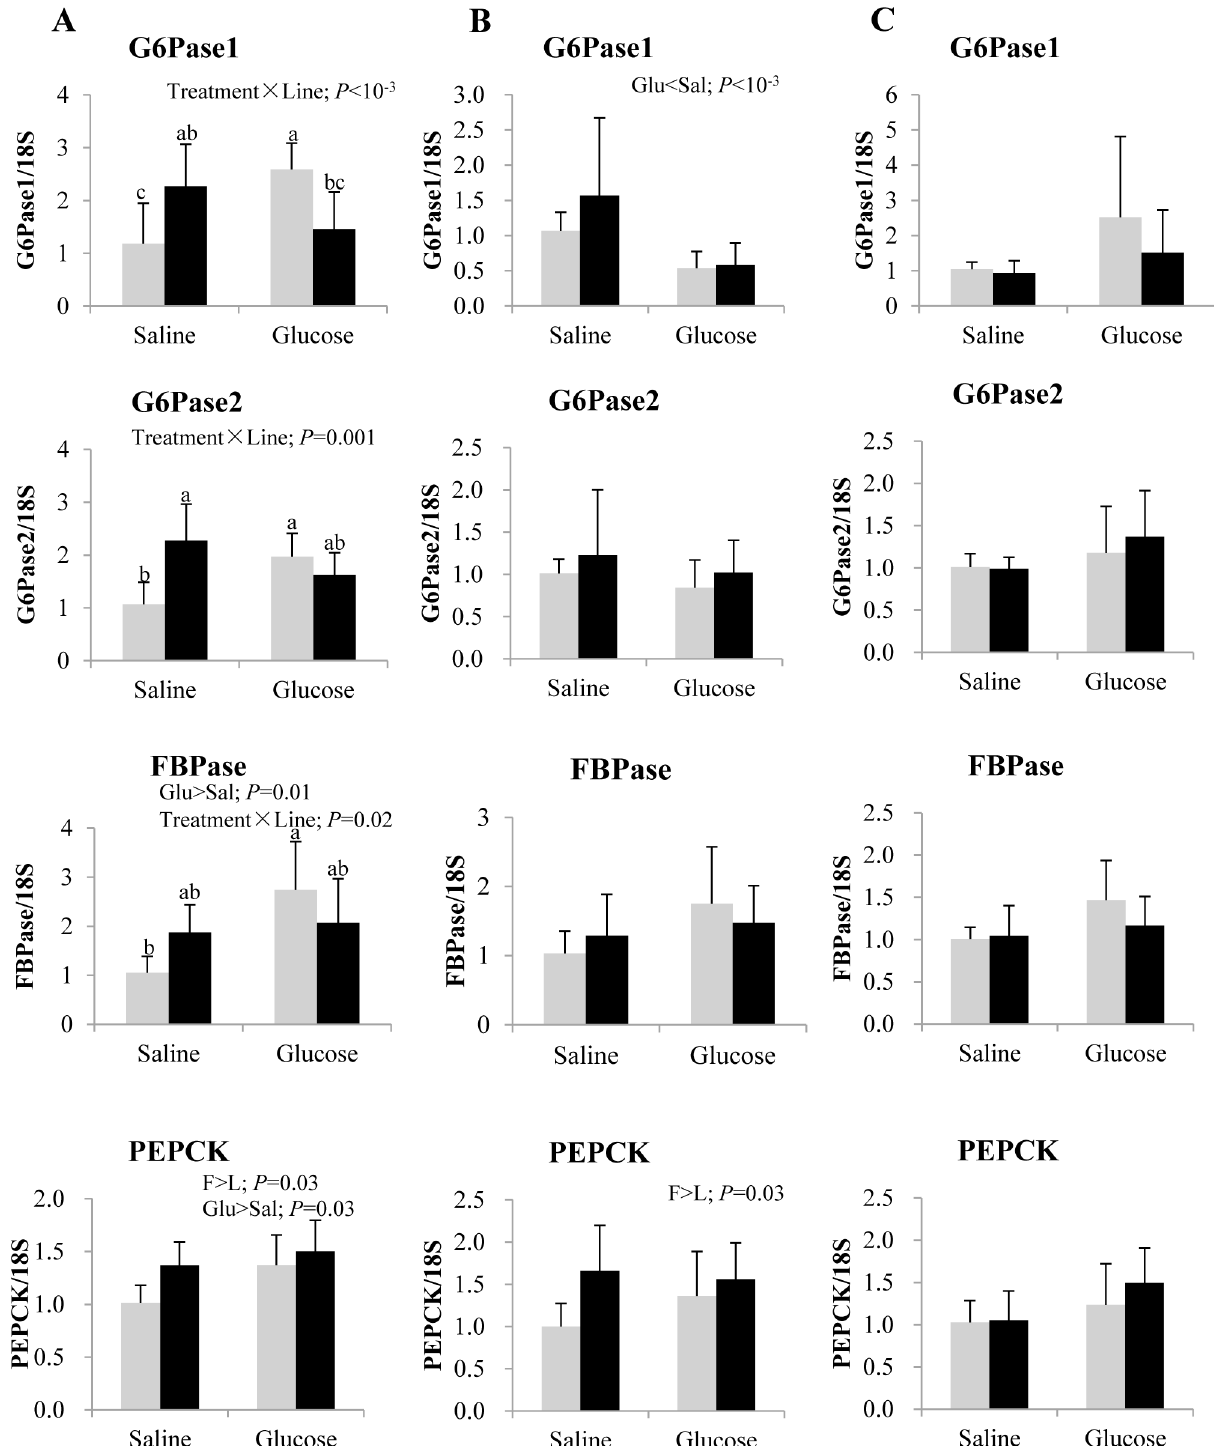
Figure 4. Gene expression of selected gluconeogenic enzymes in the liver of rainbow trout from L line (L; grey bars) and F line (F; black bars) at 3 h (A), 8 h (B) and 12 h (C) after IP administration of glucose or saline solution. Glucose-6-phosphatase isoform 1 (G6Pase1) and isoform 2 (G6Pase2), fructose 1,6-bisphosphatase (FBPase) and phosphoenolpyruvate carboxykinase (PEPCK) mRNA levels were measured using real-time quantitative RT-PCR. Expression values were normalized by 18S-ribosomal RNA transcripts. Results are expressed as means 6 SD ( n =6) and were analyzed using two-way ANOVA ( P , 0.05), followed by a Student-Newman-Keuls multiple comparison test. In case of interaction, mean values not sharing a common lowercase letter are significantly different from each other.